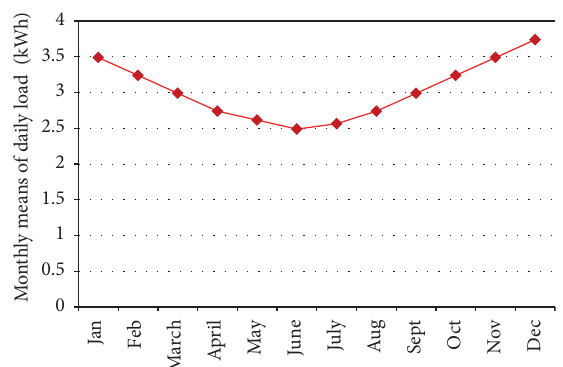
Figure 3: Monthly means of daily load profile of PV-wind hybrid system.